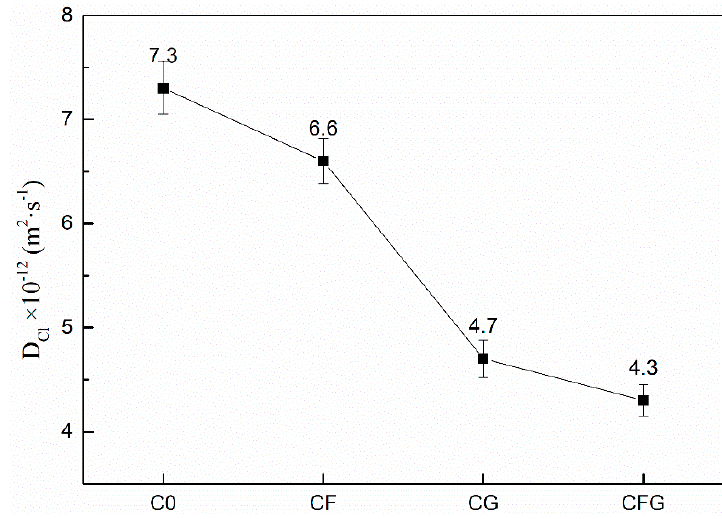
Figure 4. Chloride migration coefficient of samples.